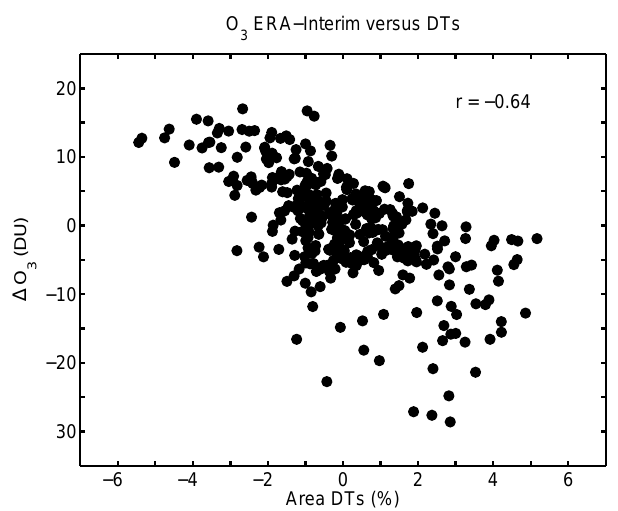
Fig. 3. Anomalies of column ozone in the 30–45 ◦ N latitude band as a function of the anomalies of the fraction of area (FA NH ) as- Fig.3. Anomaliesofcolumnozoneinthe30 ◦ –45 ◦ Nlatitudebandasafunctionoftheanomaliesofthefraction of area ( FA NH ) associated with DTs in the NH. Ozone data were derived from three satellite platforms: Earth sociated with DTs in the NH. Ozone data were derived from three Probe (EP), Nimbus 7 (N7) and OMI. Using the conservative assumption that there are only three degrees of satellite platforms: Earth Probe (EP), Nimbus 7 (N7) and OMI. Us- freedomperyearandforatwo-sidedt-test,thecorrelationforOMIdataisstatisticallysignificanteatthe95% ing the conservative assumption that there are only three degrees of level,andthecorrelationsforEarthProbeandNimbus7dataarestatisticallysignificantatthe99%level. freedom per year and for a two-sided t-test, the correlation for OMI data is statistically significante at the 95% level, and the correla- tions for Earth Probe and Nimbus 7 data are statistically significant at the 99% level.